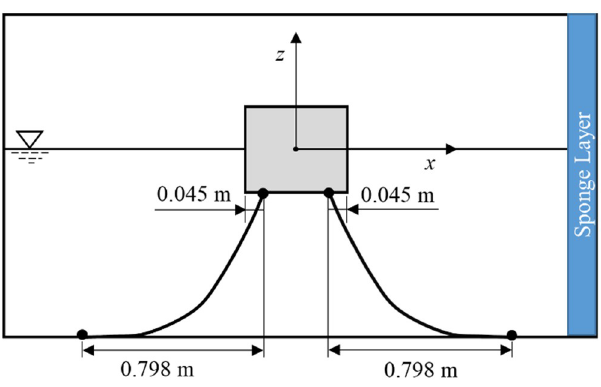
Figure 10. The mooring line configuration for a moored floating box in waves.